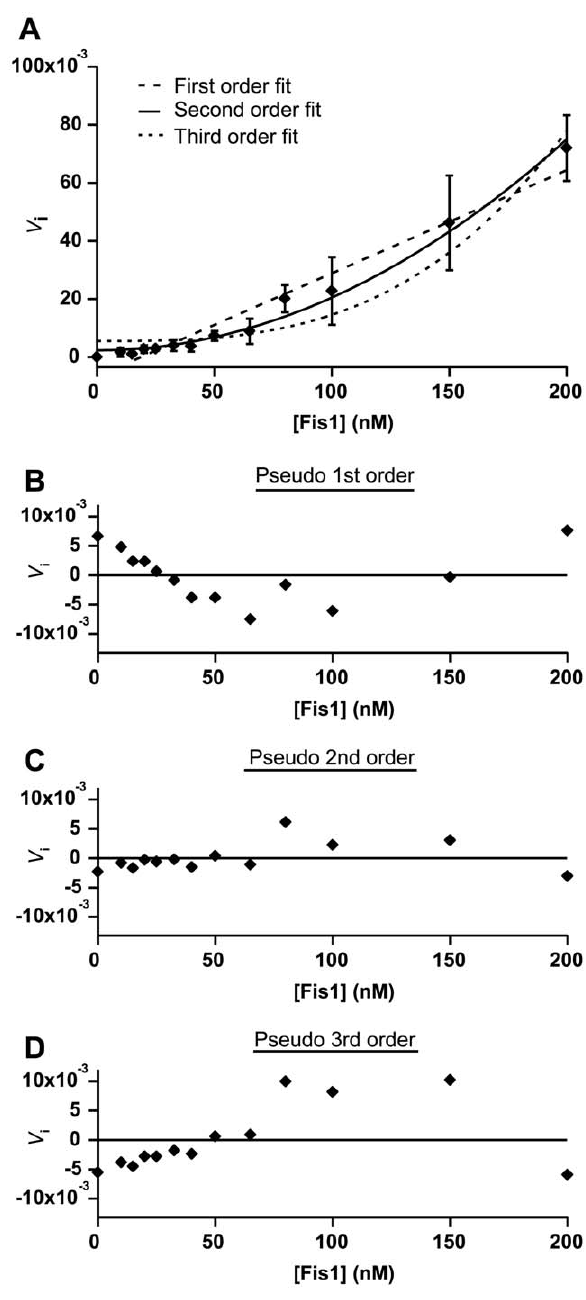
Figure 9. At least two Fis1 D TM molecules are required for vesicle clustering. The initial velocity of vesicle clustering was measured under conditions that are independent of vesicle concentra- tion to determine its dependence on Fis1 D TM concentration. (A) The initial velocity ( V i ) obtained was plotted as a function of [Fis1 D TM] and fit to a pseudo-first (— —), second (—) or third (- - -) order rate law. Residuals to the fit for pseudo-first (B), second (C) and third (D) order are shown. The data is best fit to a pseudo-second order rate law with an overall apparent rate constant of k =1.82 6 10 2 6 nM 2 1 s 2 1 and a coefficient of determination of R 2 =0.9866. For comparison, the pseudo-first order fit gave k =3.55 6 10 2 4 s 2 1 with R 2 =0.9525) and the pseudo-third order fit gave k = 9.05 6 10 2 9 nM 2 2 s 2 1 and R 2 =0.9285.